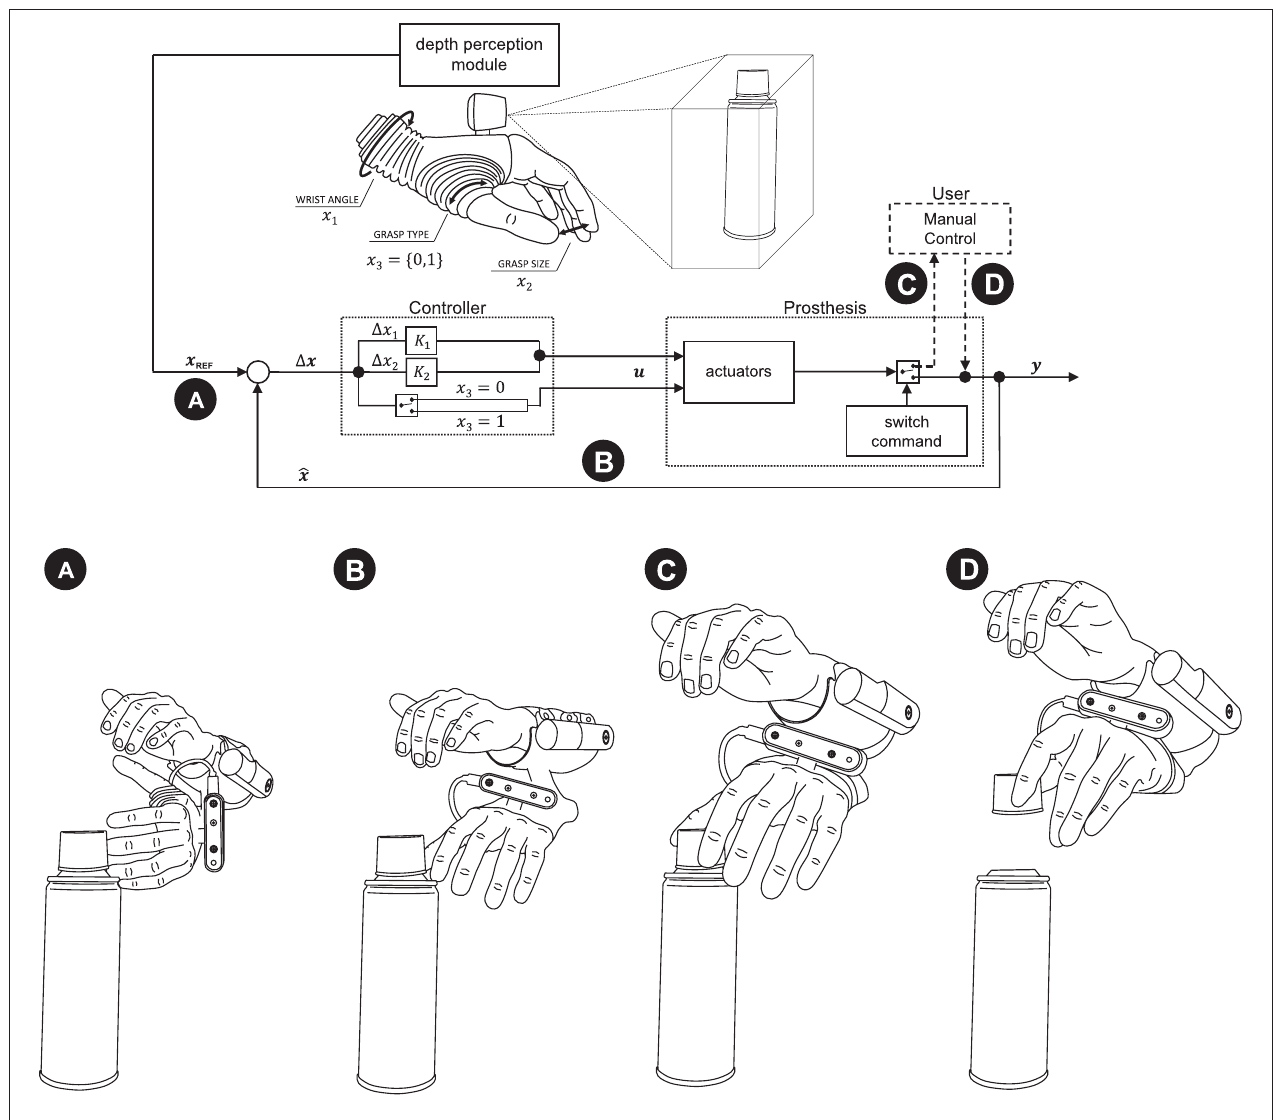
FIGURE 2 | Semi-autonomous control scheme. A proportional controller (B) continuously adjusts the prosthesis configuration ( x ) to match the reference ( x REF ) provided by computer vision (A) . The computer vision module determines the reference configuration by estimating the properties of a target object. When the subject observes that the prosthesis is pre-shaped conveniently for the grasp, he/she takes over the control and closes the hand around an object (C,D) . Annotation: x and x REF —the current and desired prosthesis state; u —prosthesis commands; x 1 , x 2 , and x 3 —angle, grasp size, and type (0—palmar,